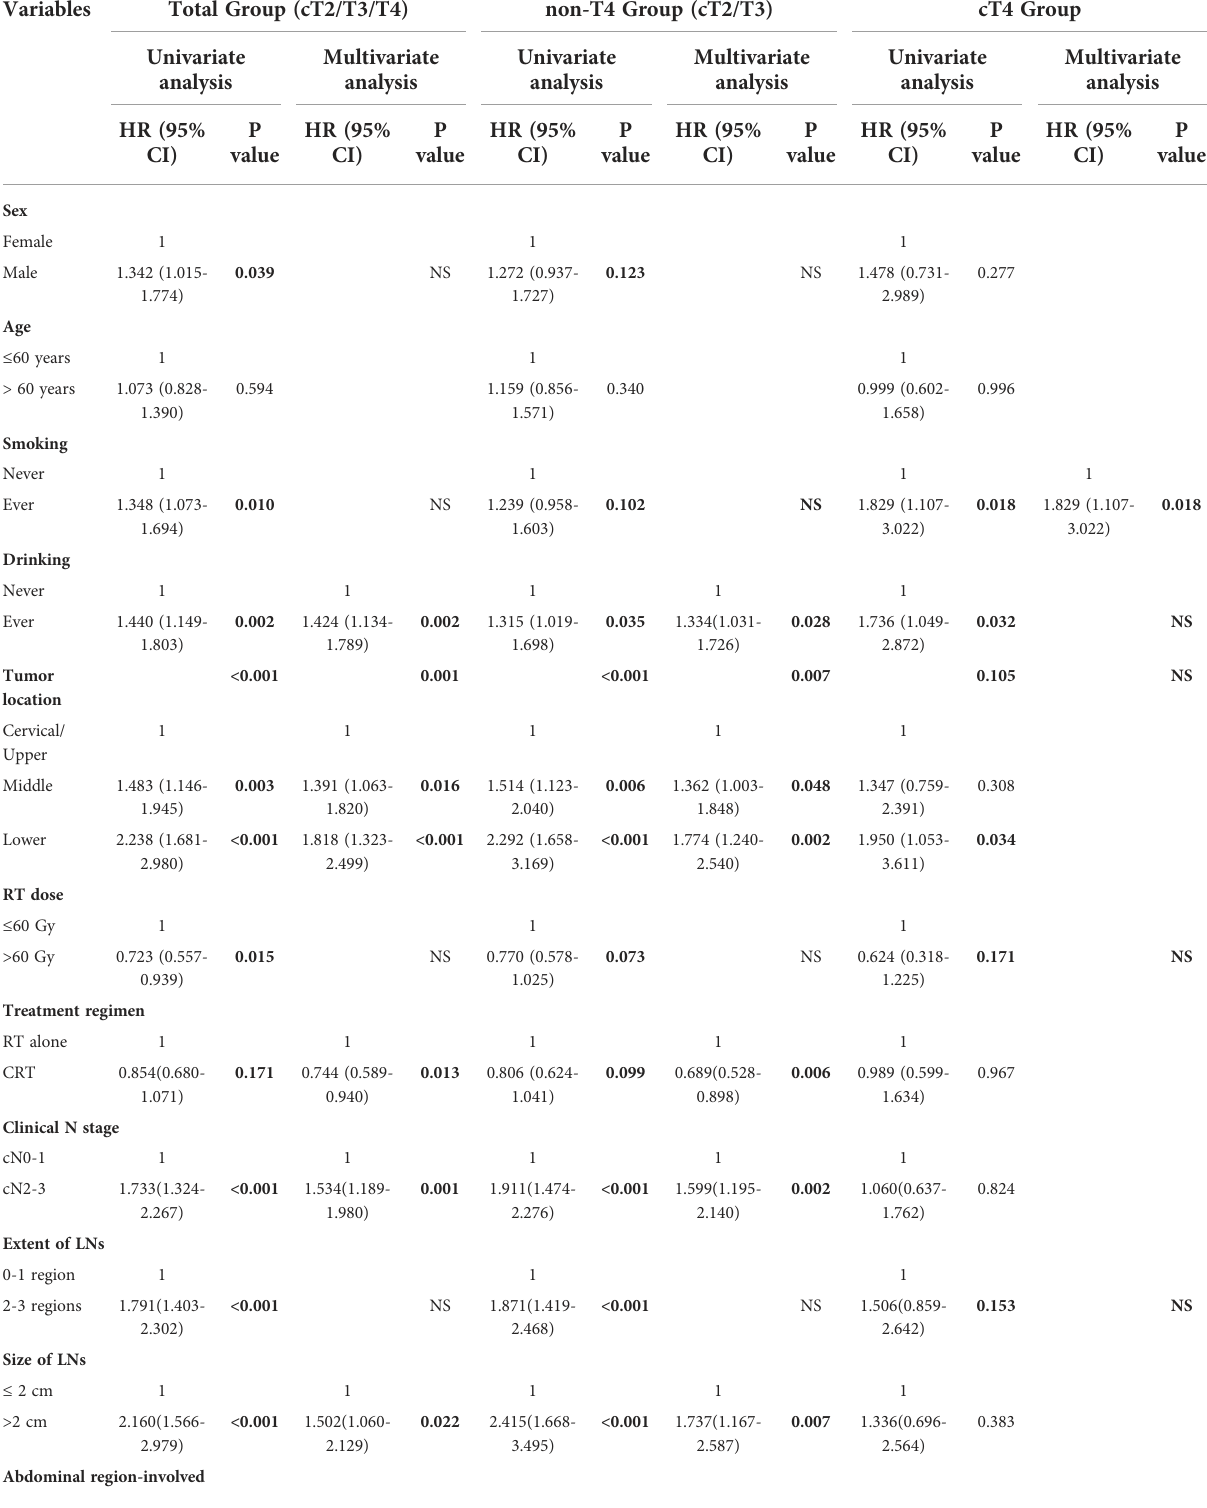
TABLE 3 Cox regression of OS for total group (cT2/3/4), non-T4 group(cT2/3) and cT4 group ESCC